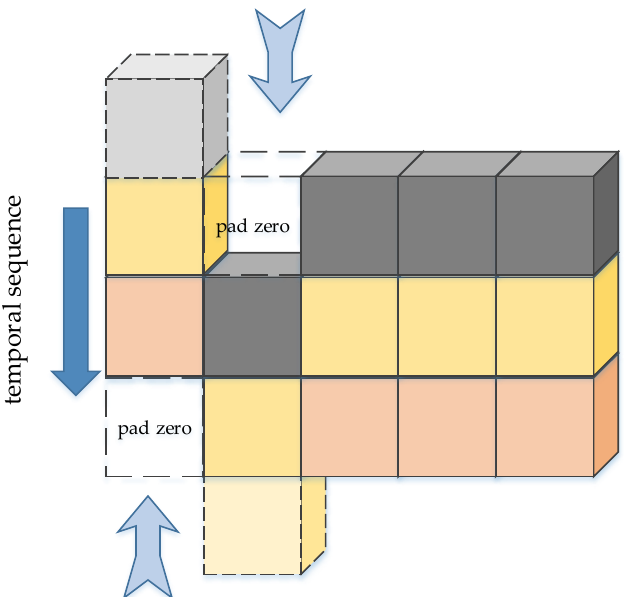
Figure 27. The illumination of TSM. TSM shifts the feature map tensor along the temporal sequence, forward or backward. The empty positions are filled with zeros.